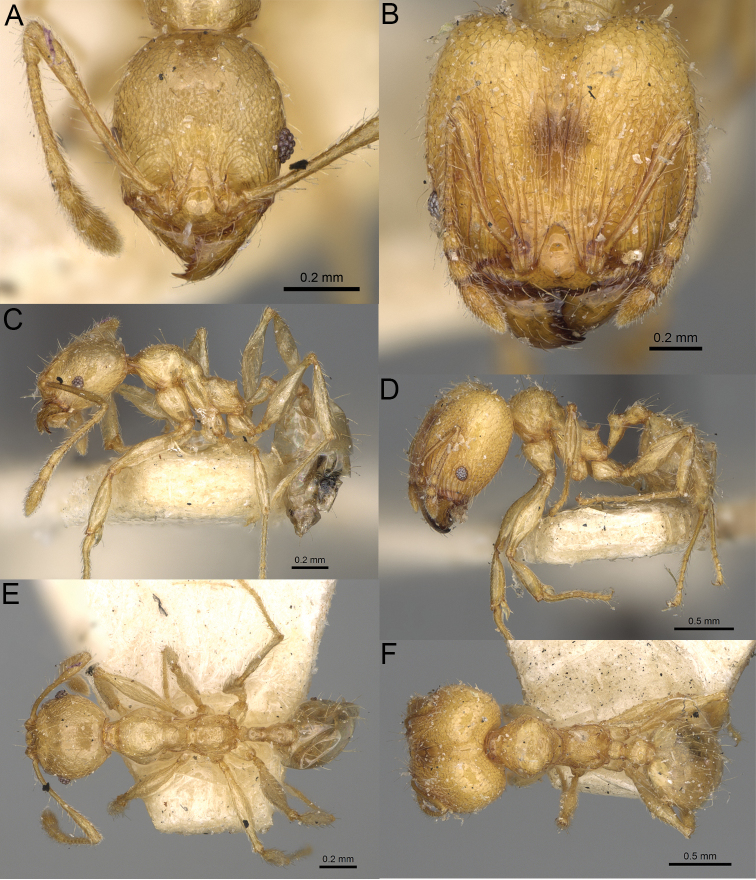
Pheidole
litigiosa Forel, full-face view (A), profile (C), and dorsal view (E) of minor worker (CASENT0923196) and full-face view (B), profile (D), and dorsal view (F) of major worker (CASENT0923195).